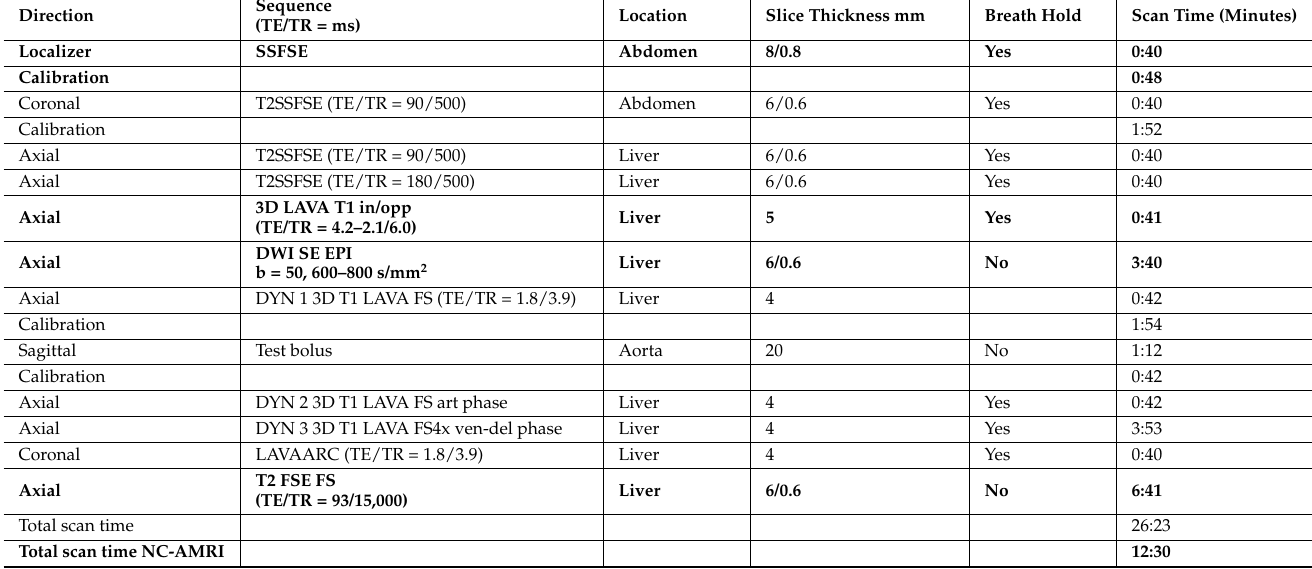
Table 1. Imaging parameters of the MRI liver protocol. Full MRI liver protocol applied for liver imaging in our center. In bold, the sequences that contribute the NC-AMRI protocol in this